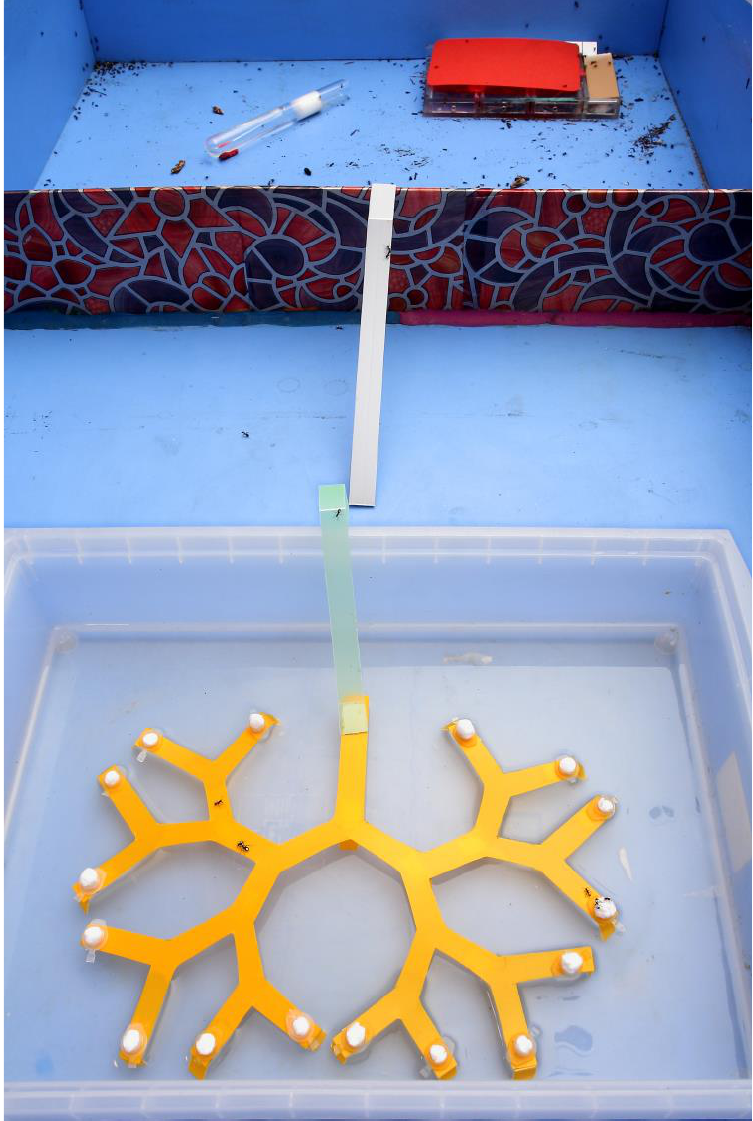
Figure 2. A laboratory arena divided into two parts, containing an artificial ant nest and a binary tree maze placed in a bath with water. This binary tree has four forks. Photo taken by Nail